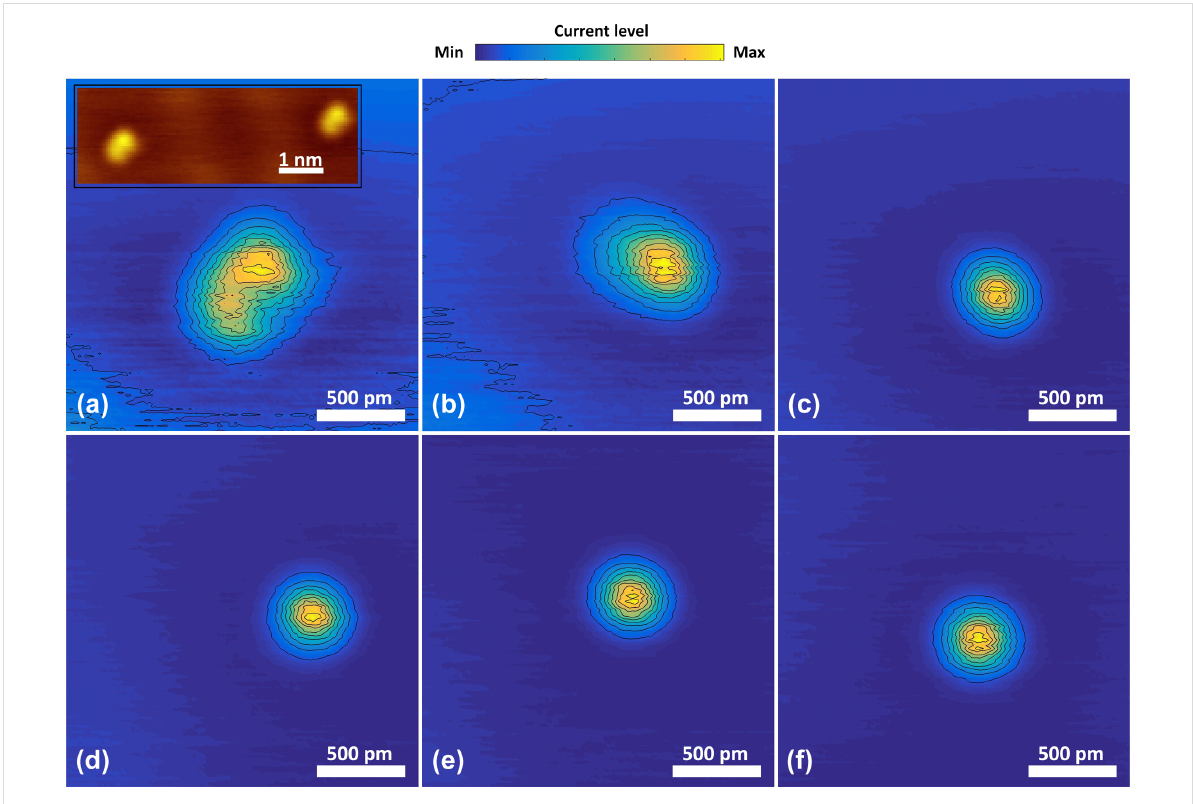
Figure 3: The six panels show constant-height images of a single adatom. Panel (a) shows a non-circular image of an adatom due to the random tip structure at the start. The inset of (a) shows a constant-current image of two separate adatoms prepared on the surface to confirm that the asym- metric structure is due to the tip. The evolution of tip apex is shown in the next panels, leading towards a symmetric and reproducible structure (b–f) . Between each of the images we applied 20 mechanical annealing cycles. The contours shown are linearly spaced in current. For ease of comparison the current levels in the images have been normalized to the maximum current level, which for the panels (a–f) are 66, 31, 26, 26 , 25 and 22 nA, re-